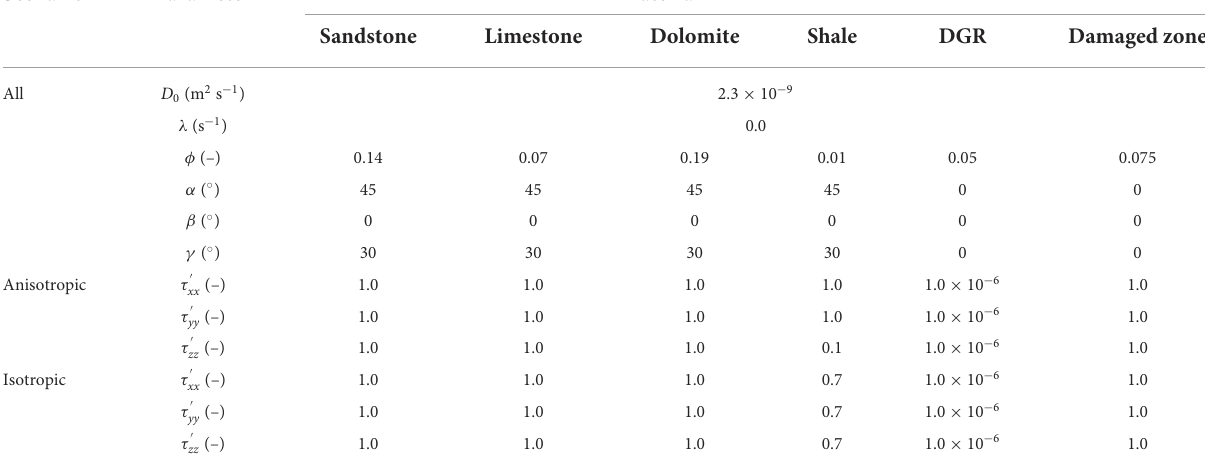
TABLE 5 Model parameters for solute diffusion from a hypothetical DGR